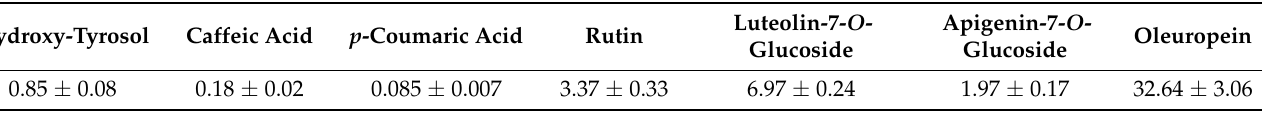
Table 1. Content (mg/g) of main phenols in OLE (mg/g of OLE). Data are expressed as mean ± standard deviation (SD) ( n =